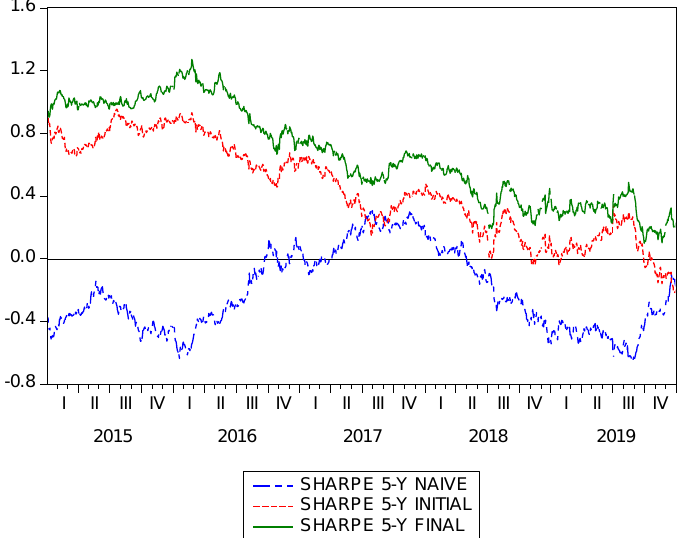
Figure 4. Sharpe ratios of strategies (5-year rolling window). This figure displays the 5-year rolling window Sharpe ratios over the out-of-sample period for the naïve strategy, the best strategy using logarithm returns, labeled as initial, and the best one using standardized returns, labeled as final.